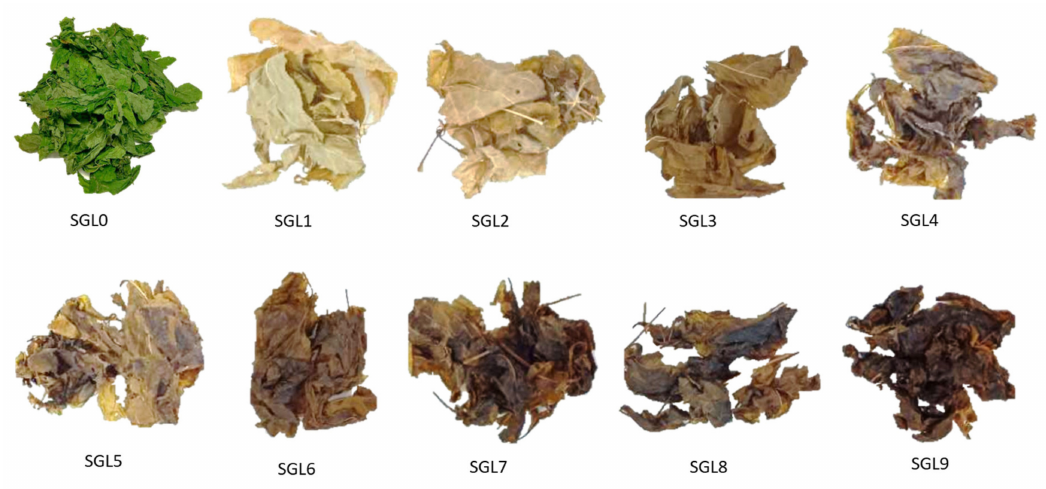
Figure 2. Pictures of steamed ginseng leaves (SGL) at di ff erent steaming